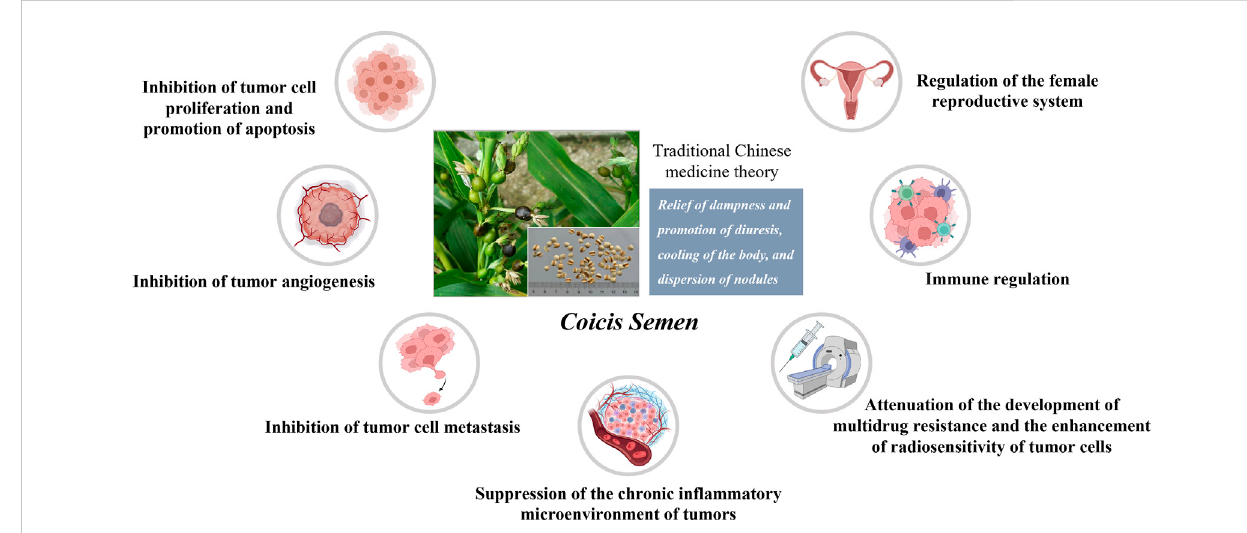
FIGURE 3 Anti-tumor effects and protection of reproductive function by Coicis Semen